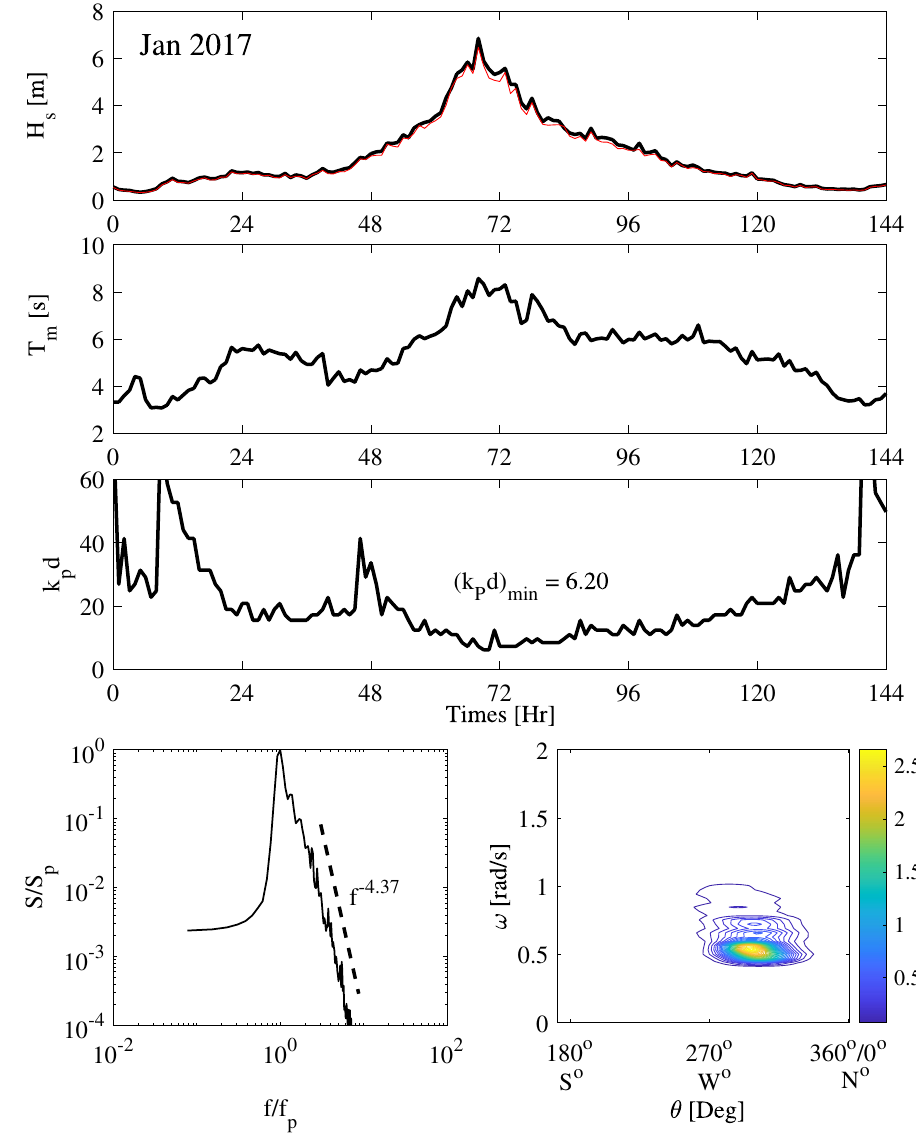
Figure 1. Metocean parameters history during January 2017 storm: (top panels) hourly variation of the 4 σ (black) and H 1 / 3 (red), mean zero-up-crossing wave period T 0 , significant wave height estimated as H s = and depth factor k p d ; (bottom-left) normalized frequency spectrum S ( f )/ S p and (bottom-right) the directional m 2 / rad/s/deg Hz m 2 / Hz spectrum S (ω , θ) ( ) at the storm peak. Here, S p ( ) and f p ( ) are the spectral [ ] [ ] [ ] amplitude and frequency at the storm